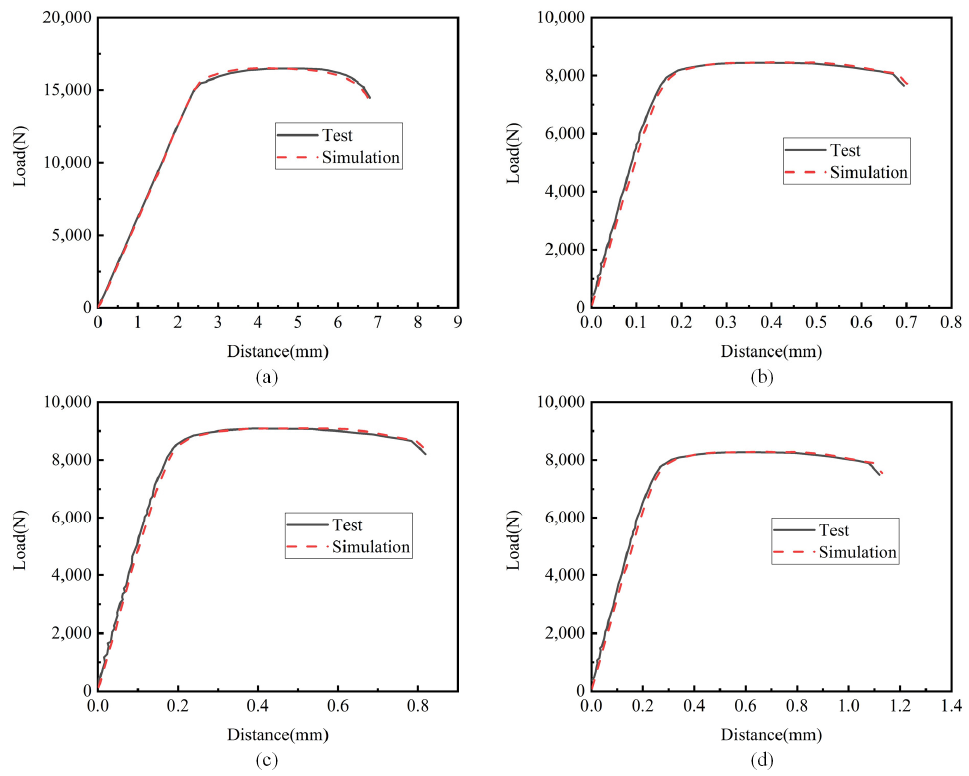
Figure 12. Force–displacement curve comparison diagram: ( a ) smooth specimen; ( b ) notch 1 specimen (R = 2.5 mm); ( c ) notch 2 specimen (R = 5 mm); ( d ) notch 3 specimen (R = 10 mm).